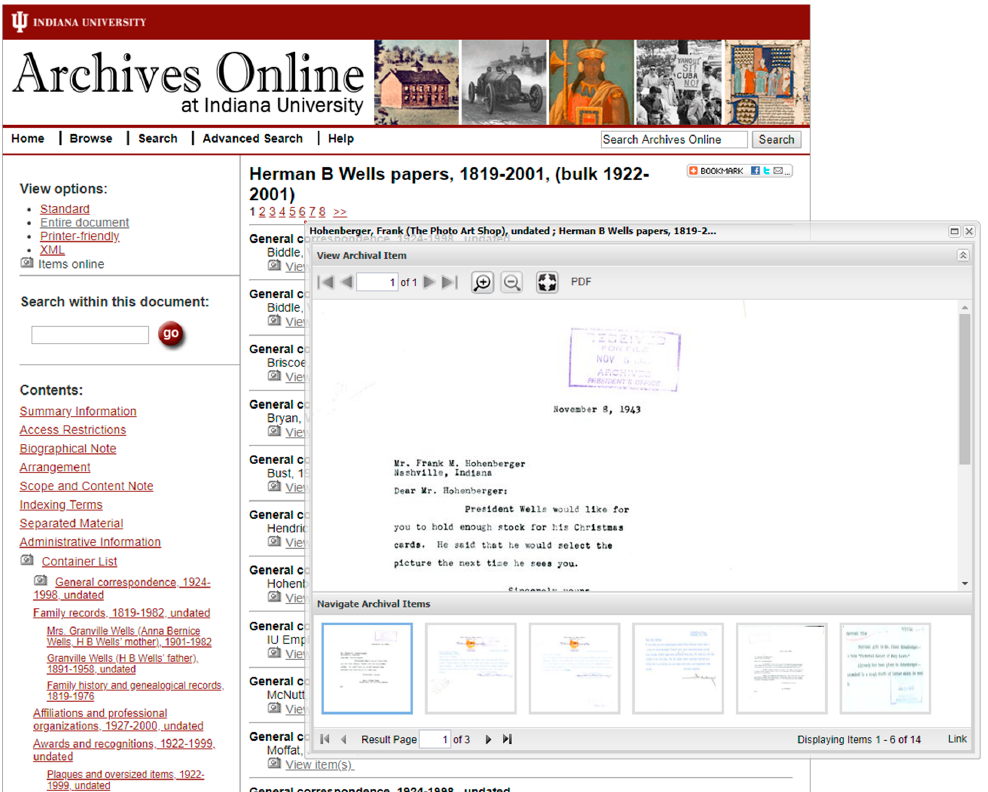
Figure 1. Screen shot of Archives Online service with viewer for digitized archival items.